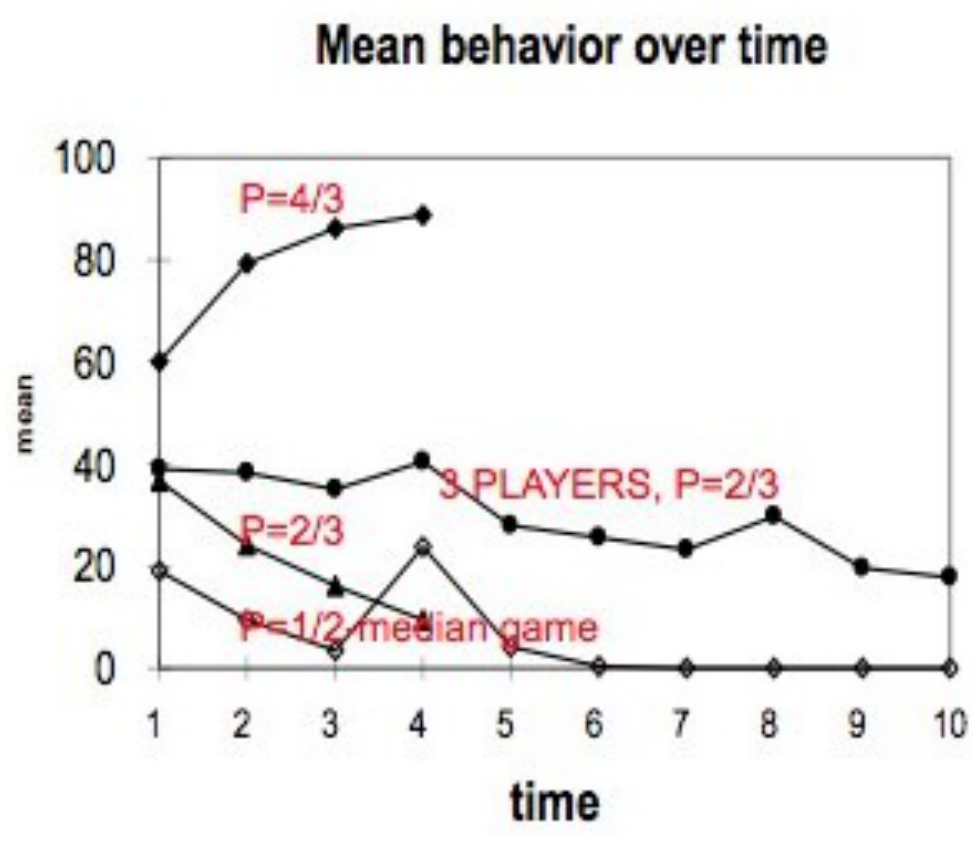
Figure 2: Mean behavior over time from Nagel (1995), Ho et al. (1998) and Duffy and Nagel (1997) Such experimentally founded inertia are especially important to take into account in